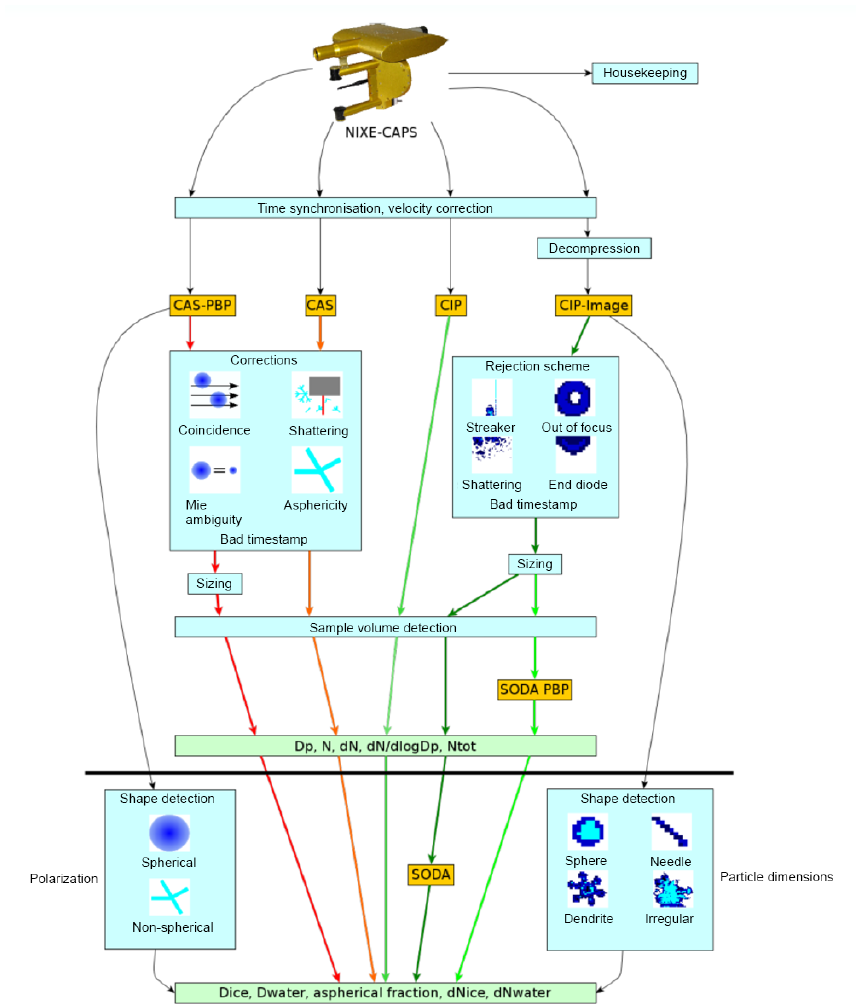
Figure 2. Flowchart of the NIXE-CAPS data processing library, NIXE-Lib. The data first undergoes time synchronization and velocity correction. It continues into various corrections of particle counts and sizing. The final steps produce a particle concentration for CAS-DPOL and CIP-Grayscale, respectively. SODA: a software program developed at the National Center for Atmospheric Research (NCAR) in Boulder, Colorado, USA. This program is embedded in the NIXE-Lib. See Meyer (2012) for more details.